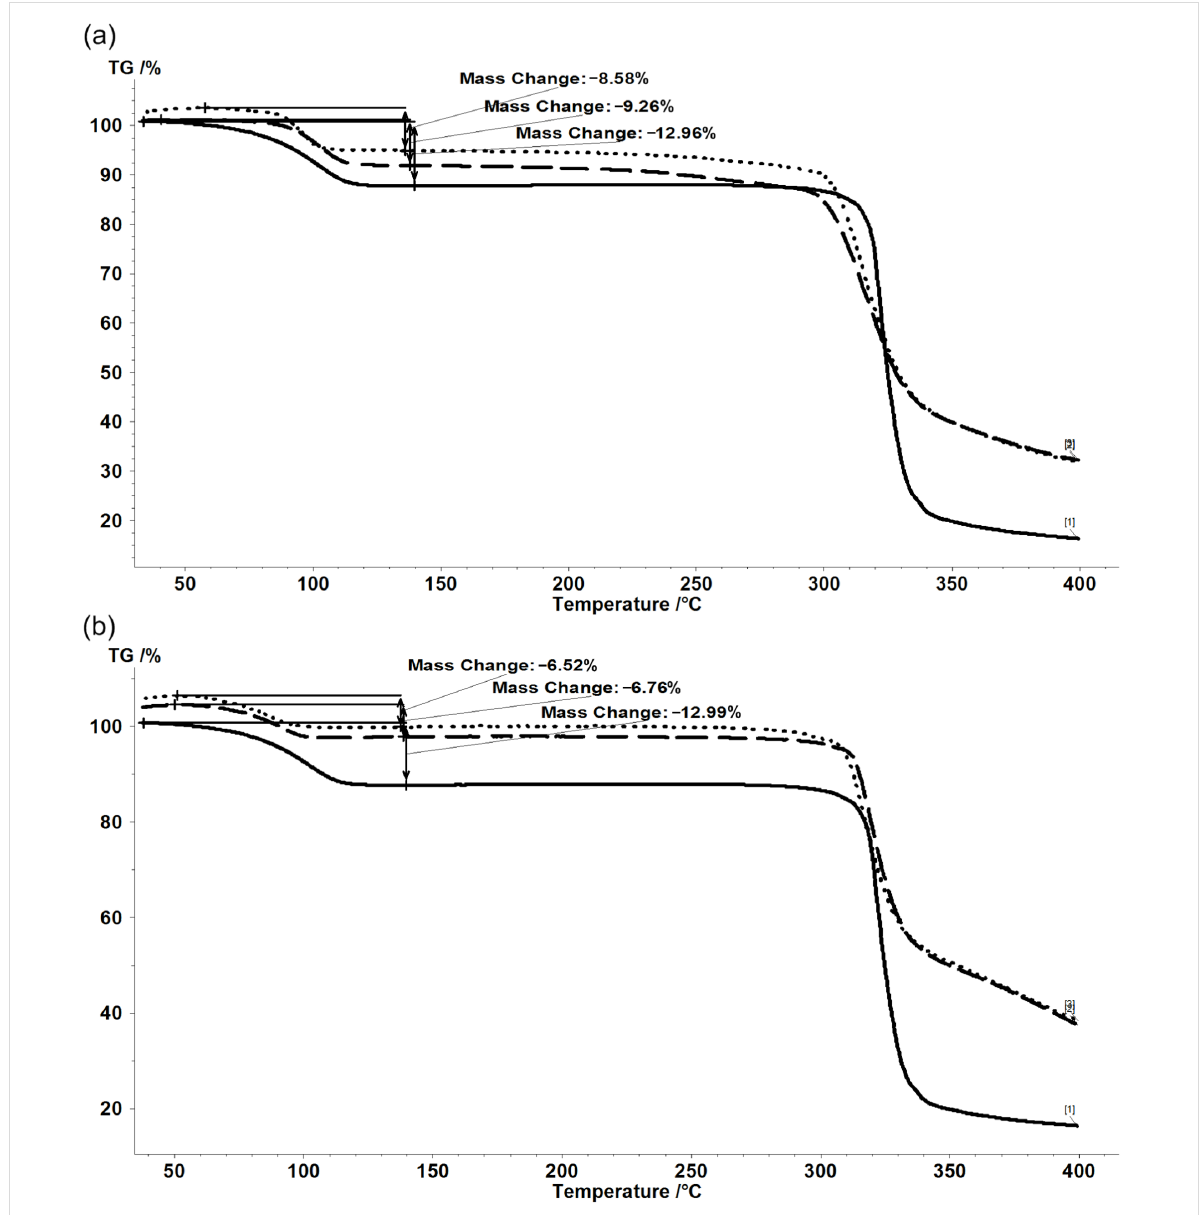
Figure 1: Superimposed thermograms for β -CD (solid line) and (a) β -CD/ASO_1:1_a&b (duplicate) or (b) β -CD/ASO_3:1_a&b (duplicate). For sam- ple name abbreviations, see Table 3.